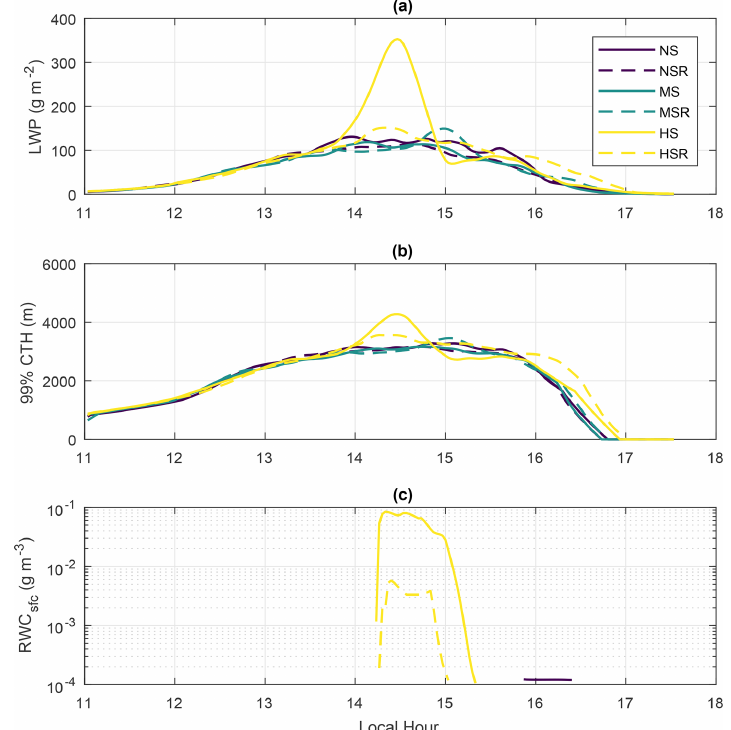
Figure 4. Time series of domain-wide characteristics: (a) averaged liquid water path (LWP), (b) 99% percentile of cloud top height (CTH), and (c) rainwater content at the surface (RWC sfc ). The time series have been smoothed by 30min moving averages for